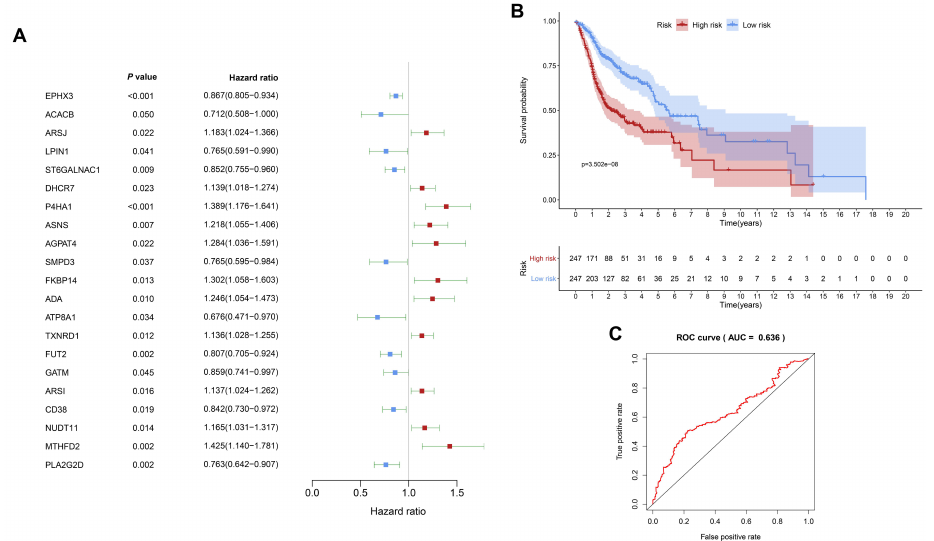
Figure 2. Immune-related metabolic enzyme (IRME)-based prognostic signature generation and prediction. ( A ) Univariate analysis revealed the OS-associated IRMEs. ( B ) An IRME-based prognostic was constructed. ( C ) The receiver operating characteristic (ROC) curve was used to evaluate the predictive accuracy of the IRME-based prognostic